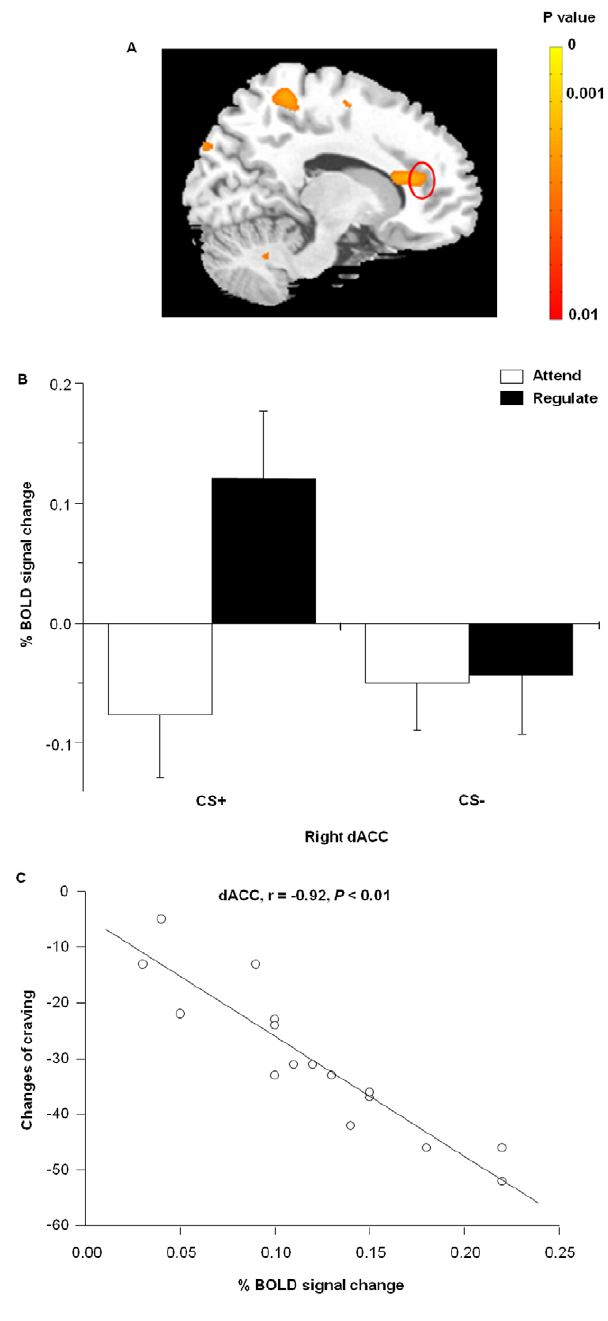
Figure 2. BOLD signals in the right dACC. (A) Activation of the right dACC reflected by the contrast between Regulate CS + and Attend CS + trials (cognitive reappraisal effects). (B) Mean beta weights from the right dACC showed an interaction of type of instruction and type of CS. (C) Craving significantly correlated with the differential dACC response to the Attend CS + trials compared with the Regulate CS + trials (r= 2 0.92, p , 0.01; Fig. 2C). Craving scores during the cognitive strategies were calculated by subtracting the craving during Regulate CS + trials from craving during Attend CS + trials for each participant.